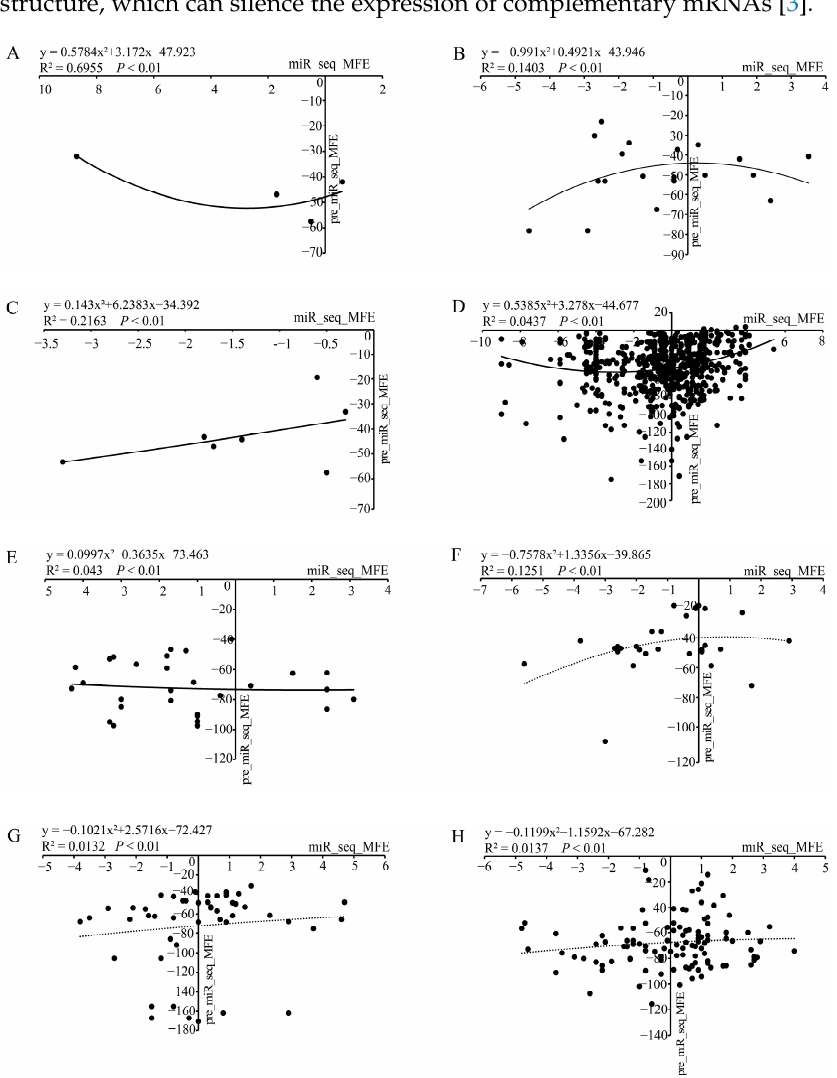
Figure 4. The relationship of minimal folding free energy (MFE) between pre-miRNA and the corresponding mature miRNA. Pre_miR_seq_MFE (precursor miRNA sequence MFE) and the corre- sponding miR_seq_MFE (mature miRNA sequence MFE) of known miRNAs in ( A – E ) from Wan et al., 2012 [16]; Cao et al., 2016 [20]; Qiu et al., 2015 [21]; Liu et al., 2021 [22]; and this study, respectively. Pre_miR_seq_MFE and the corresponding miR_seq_MFE of novel miRNAs in ( F – H ) from Qiu et al., 2015 [21]; Liu et al., 2021 [22]; and this study,